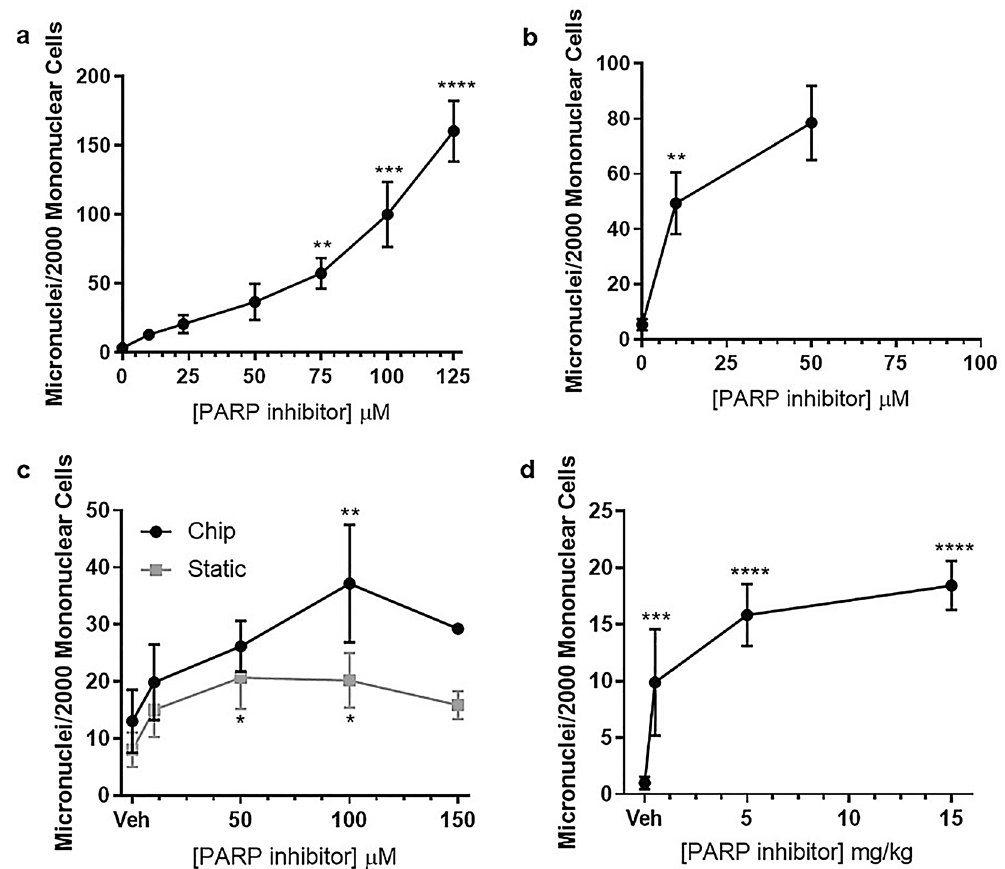
Figure 4. A dose-dependent increase and plateau in micronucleus (MN) frequency is observed in 3D bone marrow models and in vivo, in response to PARPi treatment. MN levels following PARPi treatment were compared between 2D L5178Y ( a ), 2D BM cells ( b ), 3D (chip and static) ( c ) and in vivo ( d ). Data were recorded as MN/2000 mononuclear. 2D and 3D conditions: n = 3 ( n = 2 for 150 µM PAPRi in chip and 50 µM in 2D BM cells); In vivo groups: n = 5. Data are presented as mean ± SD. Significance compared to vehicle control (one-way ANOVA with Dunnett’s post-test (* p < 0.05; ** p < 0.01; *** p < 0.001; **** p <